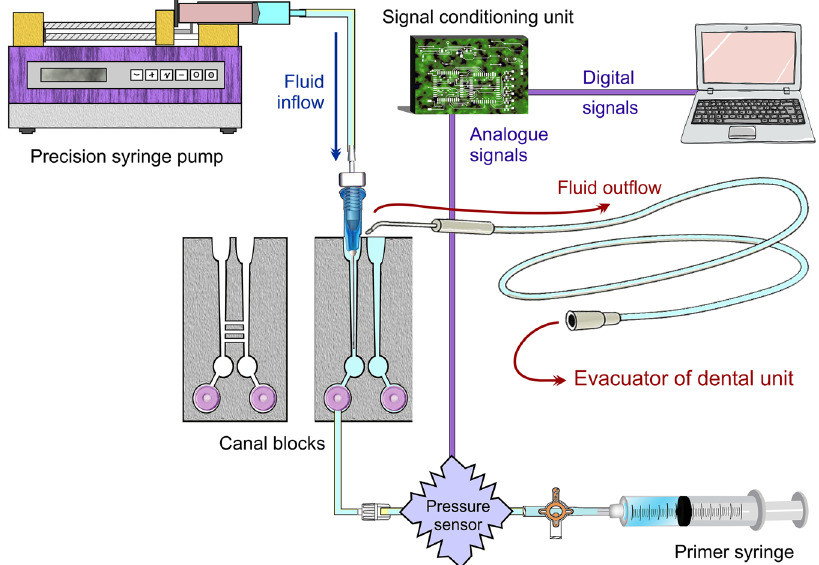
Figure 3. Schematic of fluid inflow-outflow and pressure signal recording of the experimental setup (http:// www.corel.com/en/clipart-and-photos/). “Copyright ( c ) 2017 Franklin Tay and its licensors. All rights reserved.”